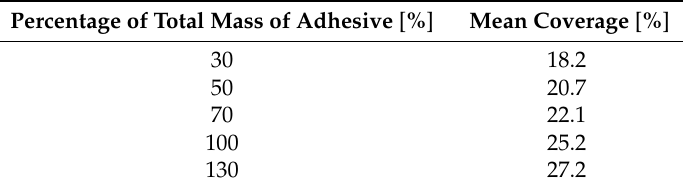
Table 6. Variation of the total mass of adhesive.